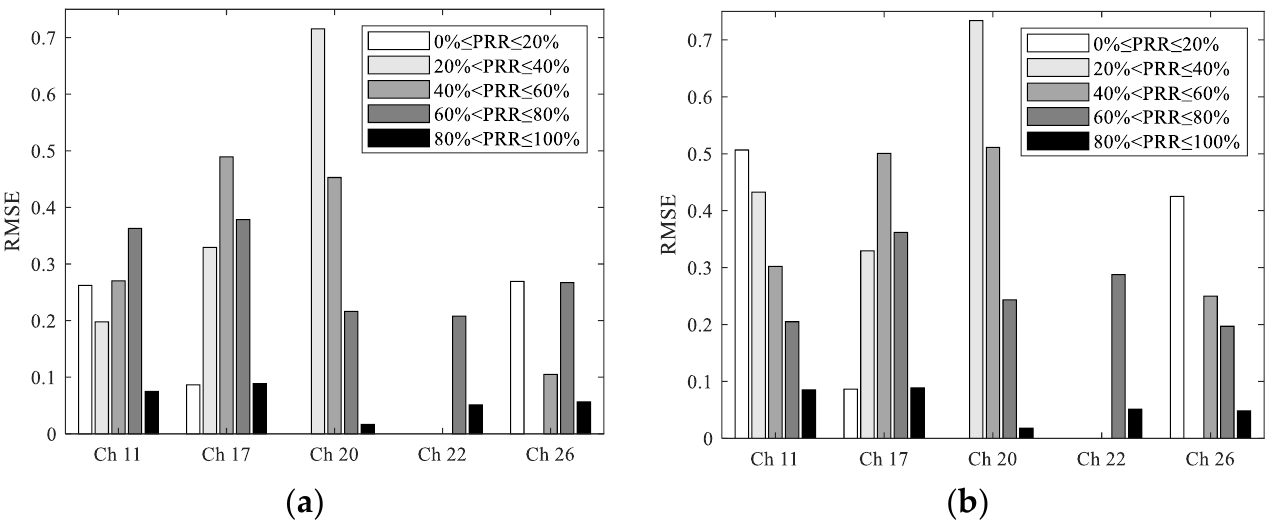
Figure 9. RMSEs of the TH-SNR model and LR-SNR model under different channels: ( a ) RMSE of the TH-SNR model for different PRR ranges; ( b ) RMSE of the LR-SNR model for different PRR ranges.